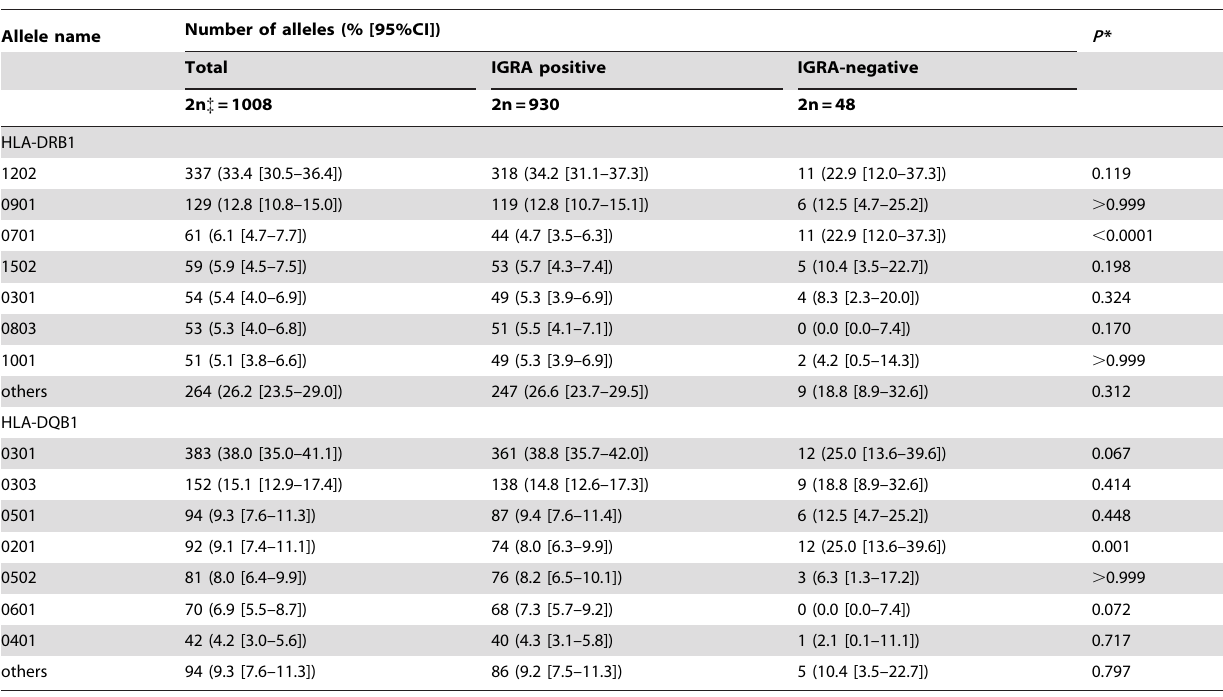
Table 3. Frequencies of HLA class II alleles and QFT-IT positive/negative results.